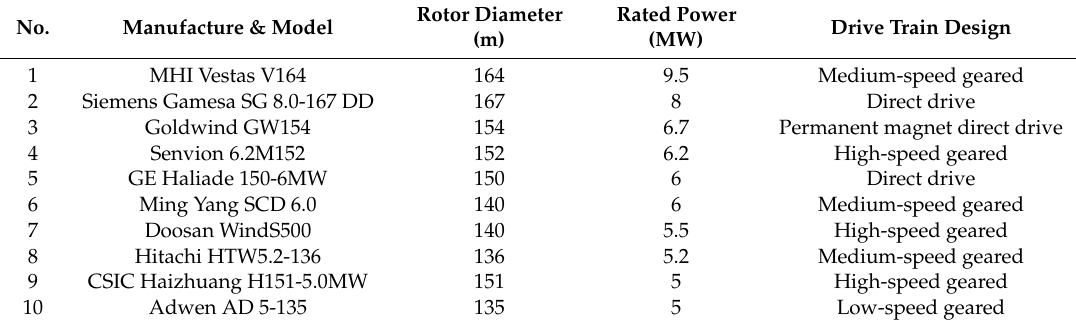
Table 1. The ten largest commercial wind turbines in the world currently under development.